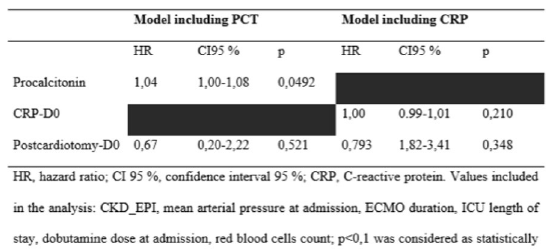
Fig. 1 Compared values of PCT and CRP at day 0 according to sepsis Table 1 Multivariable analysis of factors associated with sepsis occurrence in the vv‑ECMO population